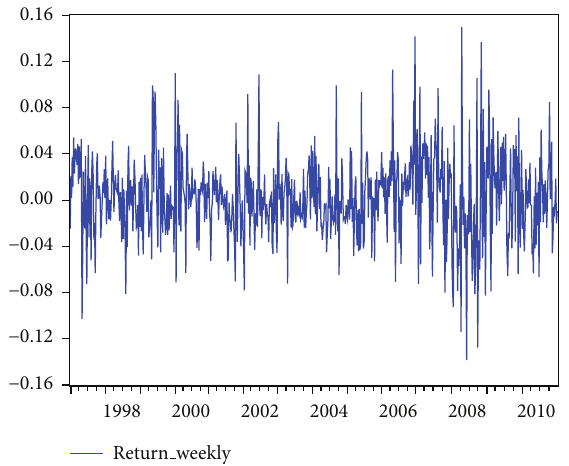
Figure 2: Time series of Shanghai composite index returns.